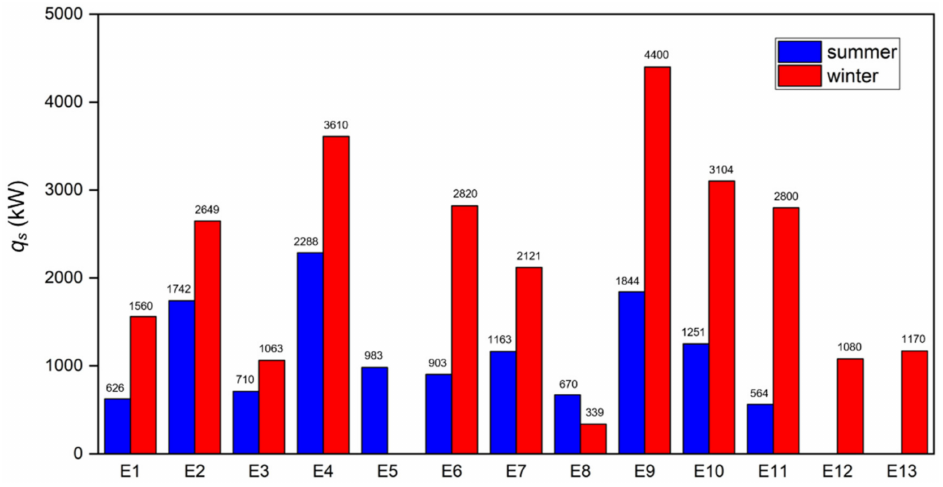
Figure 5. Heat load of heat exchangers in the first step. Table 6. Operation parameters of the first step.